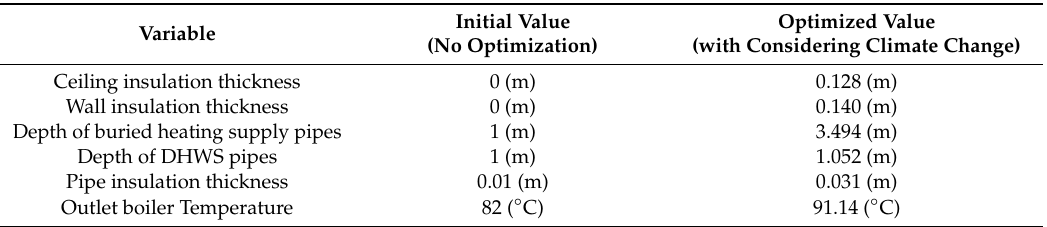
Table 9. Comparison between the initial and the optimized values of the studied variables.